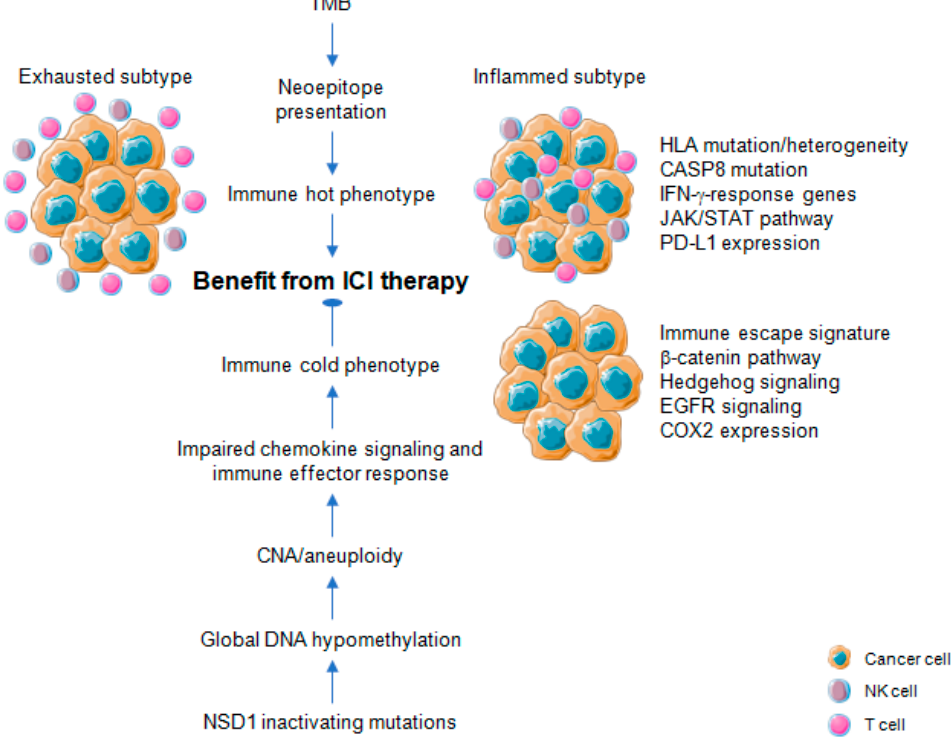
Figure 3. Association of molecular traits related to cancer immune phenotypes and efficacy of immune checkpoint inhibition therapy for head and neck cancer. Tumor mutational burden (TMB) is an indirect measure of tumor antigenicity generated by somatic mutations and neoepitope presentation, causing an immune hot phenotype. The immune hot phenotype emerges as either inflamed or exhausted subtype. An immune cold phenotype is characterized by impaired chemokine and immune effector response, accompanied by specific patterns of copy number alterations (CNA) or aneuploidy. Global DNA hypomethylation promotes chromosomal instability, particularly involving large-scale alterations leading to aneuploidy and has been observed in tumors with NSD1 inactivating mutations. Distinct molecular traits are associated with immune hot or cold phenotypes some of which serve as predictive markers for the efficacy of immune checkpoint inhibition (ICI) therapy.